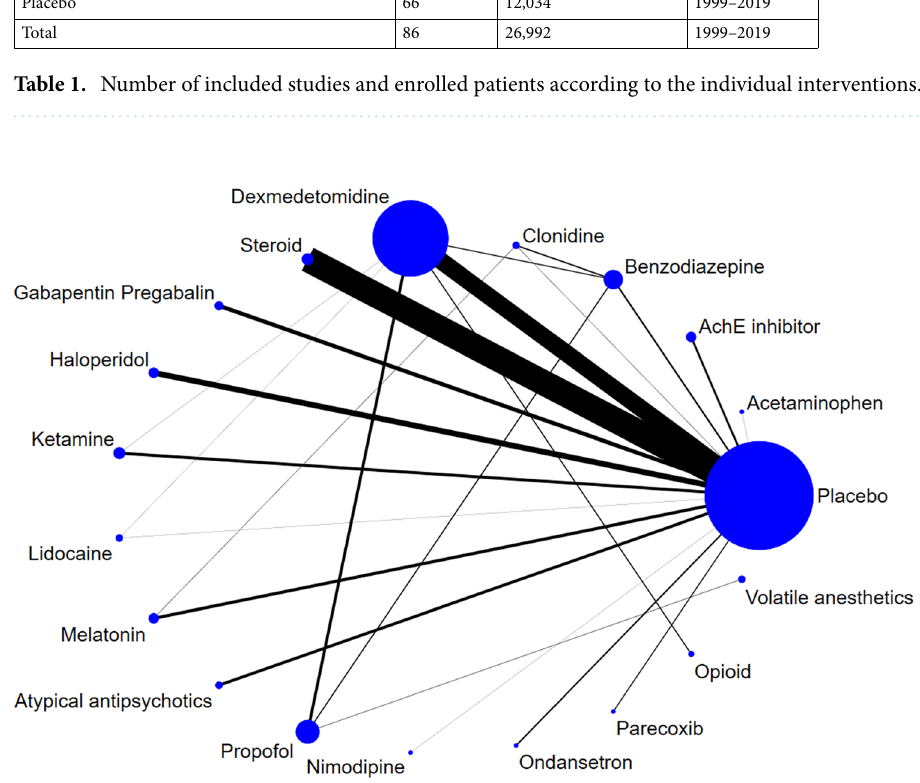
the loop of control-dexmedetomidine-ketamine (ROR = 1.68, 95% CI 1.00–146.83, τ 2 = 1.007, P = 0.467). All direct and indirect effect sizes for all pairs of comparison were shown in Supplemental Table S2. The transitivity assumption of network meta-analysis was evaluated by reviewing the individual study base- line characteristics. The demographic information of each included study is shown in Supplemental Table S1. None of the regression coefficients of our meta-regression analysis was found to be statistically significant (Age: r = − 0.007, 95% CI − 0.03 to 0.02, P = 0.556; Proportion of male: r = − 0.003, 95% CI − 0.02 to 0.01, P = 0.628) (Supplemental Figure S2).